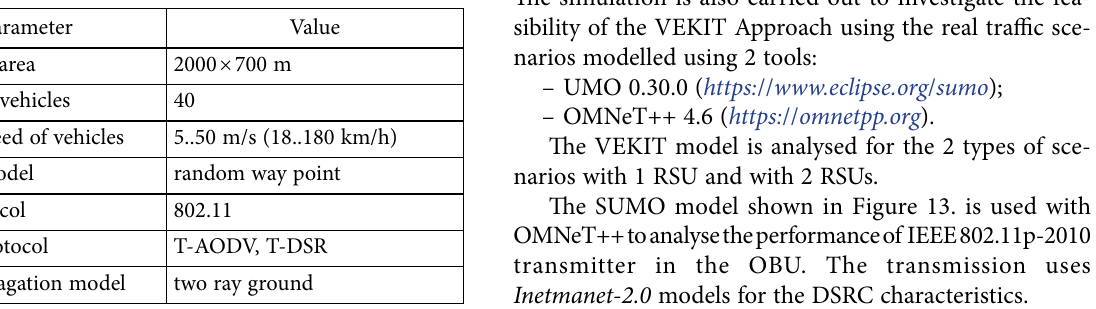
Table. Simulation